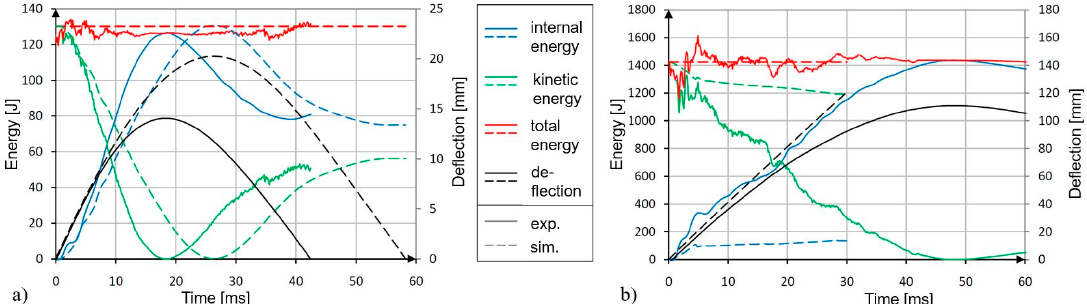
Figure 12. Comparison of experimental and numerically determined deformations and energies of bumper bracket configuration (b), layup: 9 layers ± 30 ◦ (2D biaxial braid): ( a ) 5 km / h (drop height 0.1 m), ( b ) 16 km / h (drop height 1